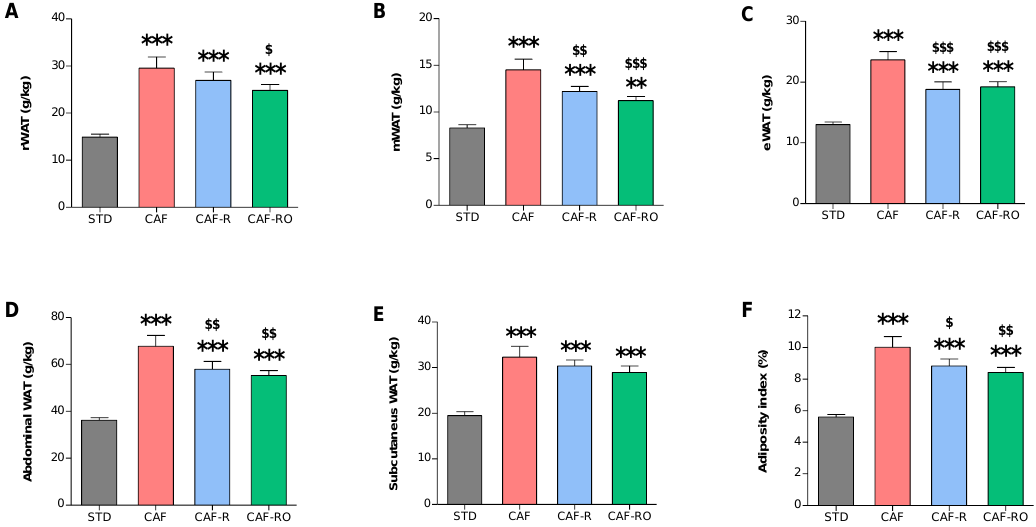
Figure 1. Effects of the dietary treatments on the relative weight of the retroperitoneal WAT ( A ), mesenteric WAT ( B ), epididymal WAT ( C ), abdominal WAT ( D ) and subcutaneous WAT ( E ), and on the adiposity index ( F ). Tissue weights in grams were relativized to the total body weight in kg. Data are expressed as the mean ± SEM. ** p < 0.01, *** p < 0.001 vs. STD group; $ p < 0.05, $$ p < 0.01, $$$ p < 0.001 vs. CAF group.